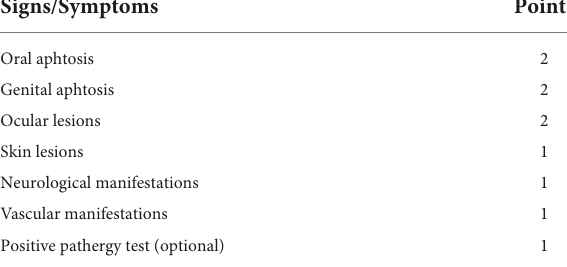
ABD had a positive pathergy reaction. For the first time, numeric scores were assessed for every symptom: recurrent genital aphtosis scored 2 points, recurrent oral aphtosis scored 1 point, cutaneous lesions (erythema nodosum–like lesions, pseudofolliculitis, or papulo-pustular lesions) scored 1 point, ocular lesions (anterior/posterior uveitis, retinal vasculitis) scored 1 point, positive pathergy test scored 1 point, ileocecal ulcerations (excluding inflammatory bowel disease and intestinal tuberculosis) scored 1 point. ABD could be diagnosed with at least 3 points, and the presence of HLA-B51 could be useful for the diagnosis (27,